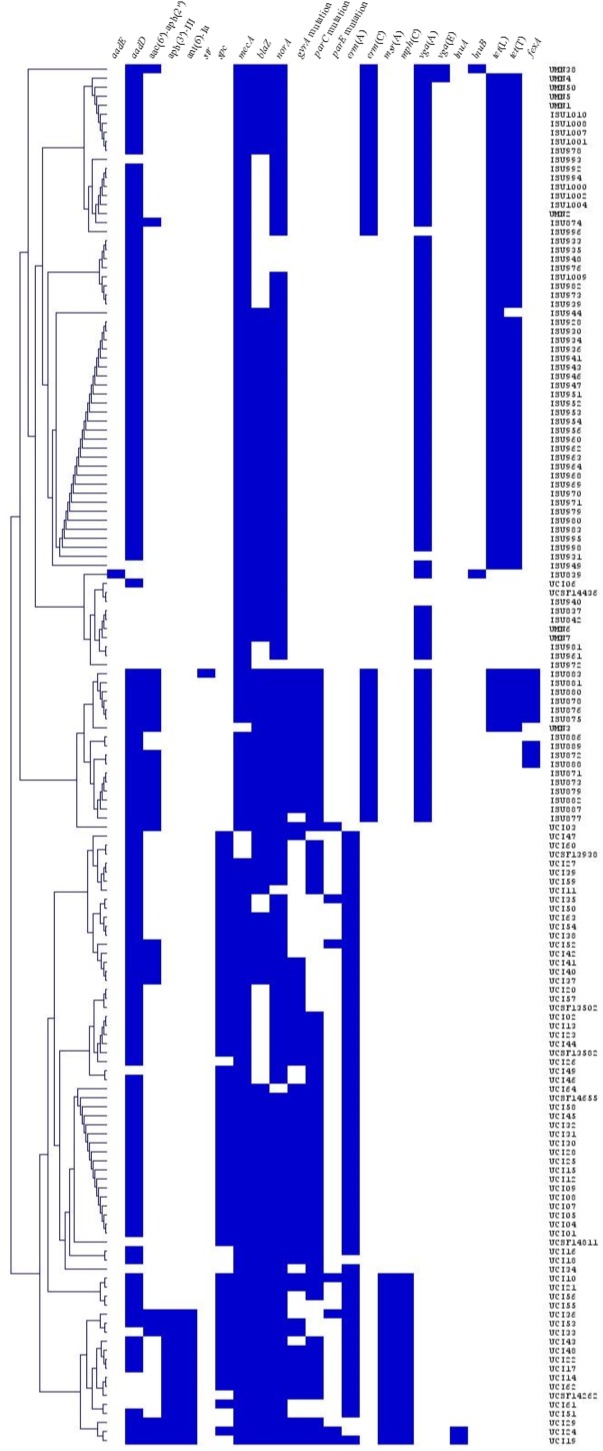
Hierarchical cluster dendrogram displaying the relatedness of the MRSA ST5 isolates based on the presence or absence of AMR genetic elements. Isolates are grouped by average hierarchical clustering based on Euclidean Distance. AMR genetic elements are listed at the top, isolate names are listed to the right, and presence (blue) or absence (white) of genes is indicated.